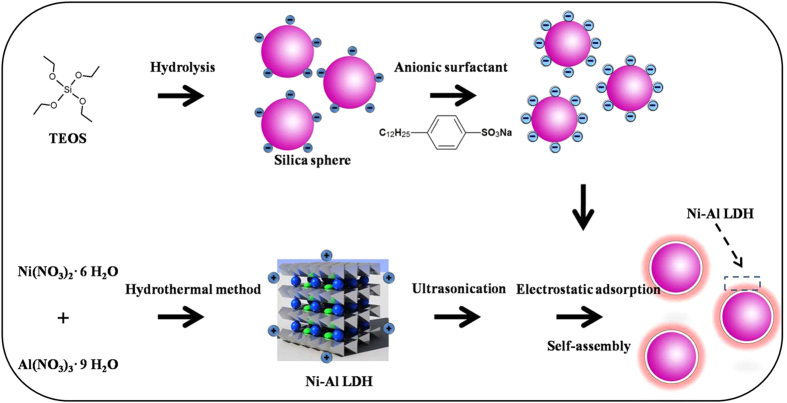
Schematic diagram of the stepwise preparation of electro-responsive SiO2@Ni-Al LDH composites.